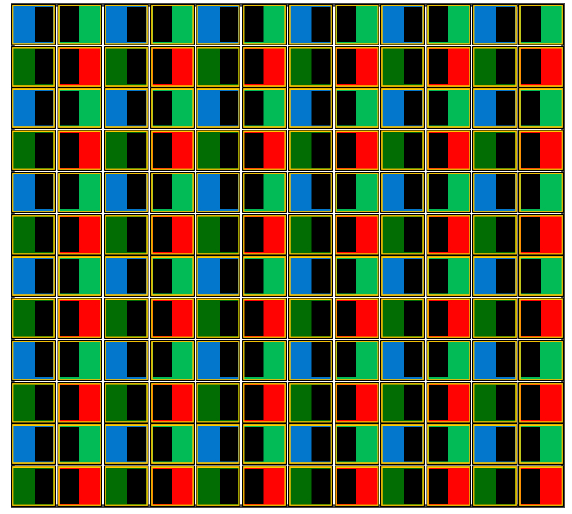
Figure 3. The phase detection sensor for the proposed sensor-based PDAF system. Green masks in the odd and even lines have different brightness, since a real system has different